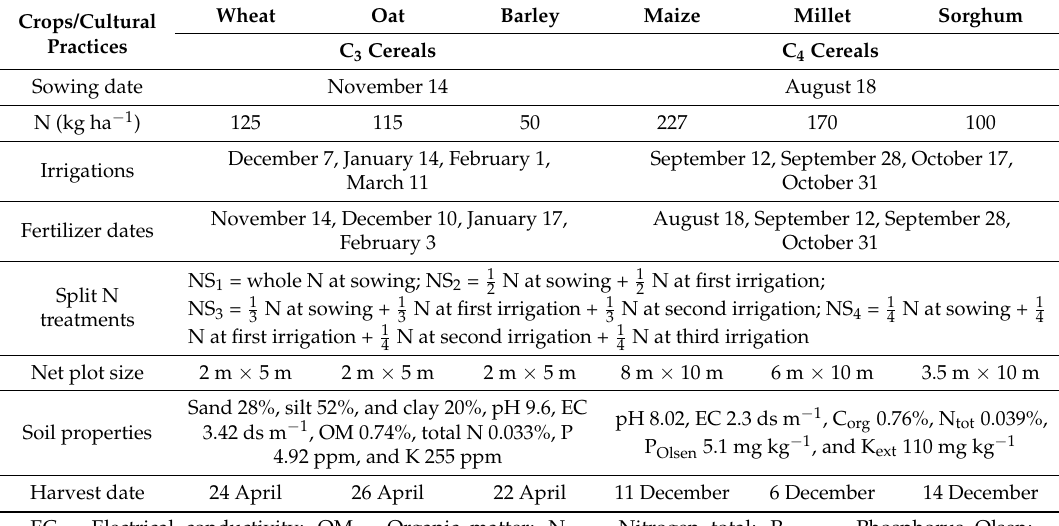
Table 3. Agronomic practices for C 3 winter (wheat, oat, and barley) and C 4 summer (maize, millet, and sorghum)